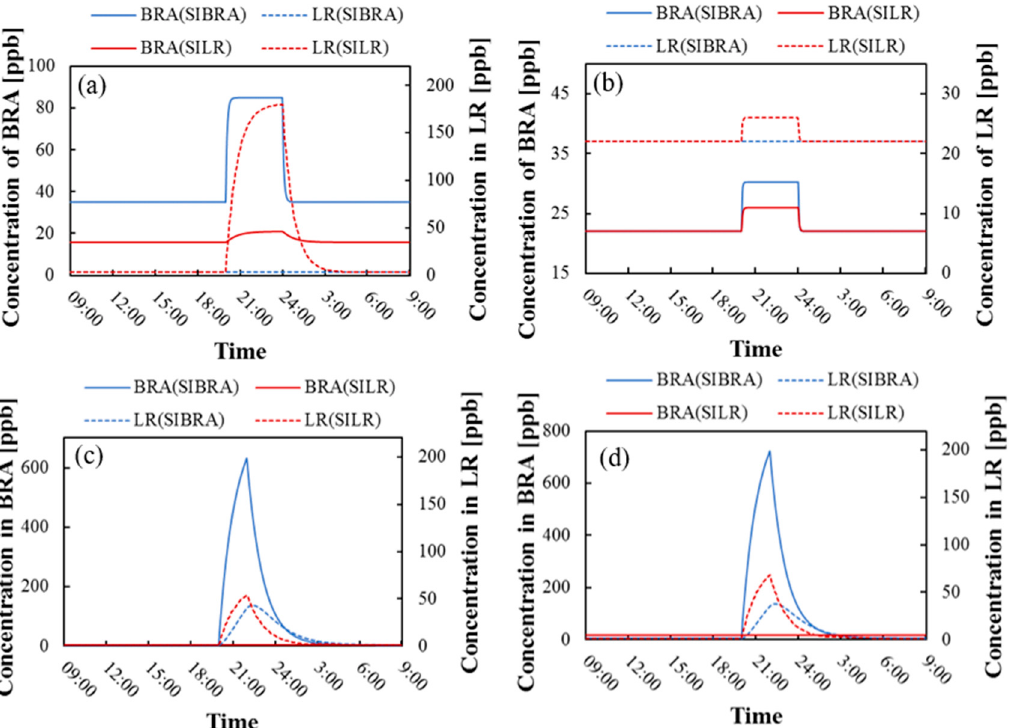
Figure 5. Ozone sources in Bedroom A and the living room on the condition that ( a ) inner doors were closed in summer, ( b ) inner doors were open in summer, ( c ) inner doors were closed in winter, ( d ) inner doors were open in winter. BRA and LR refer to the ozone concentration of Bedroom A and the living room, respectively. SIBRA and SILR mean that sources were located in Bedroom A and the living room respectively.